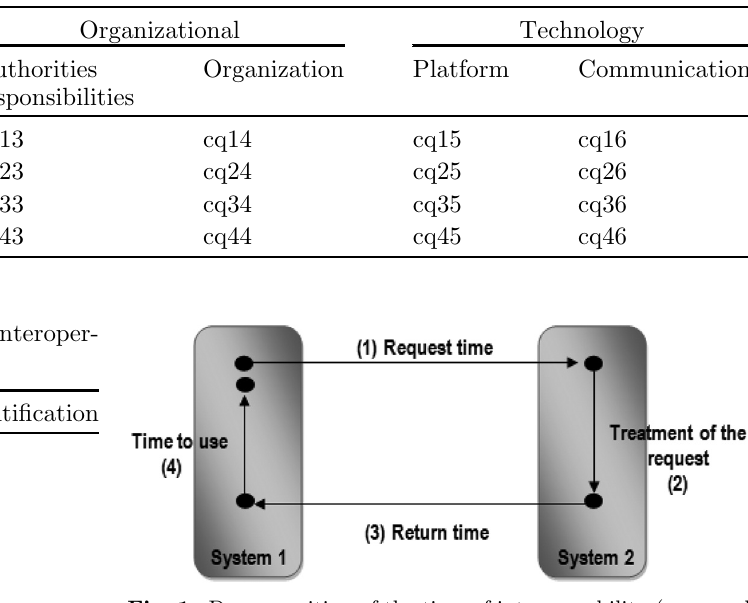
Fig. 1. Decomposition of the time of interoperability (proposed by